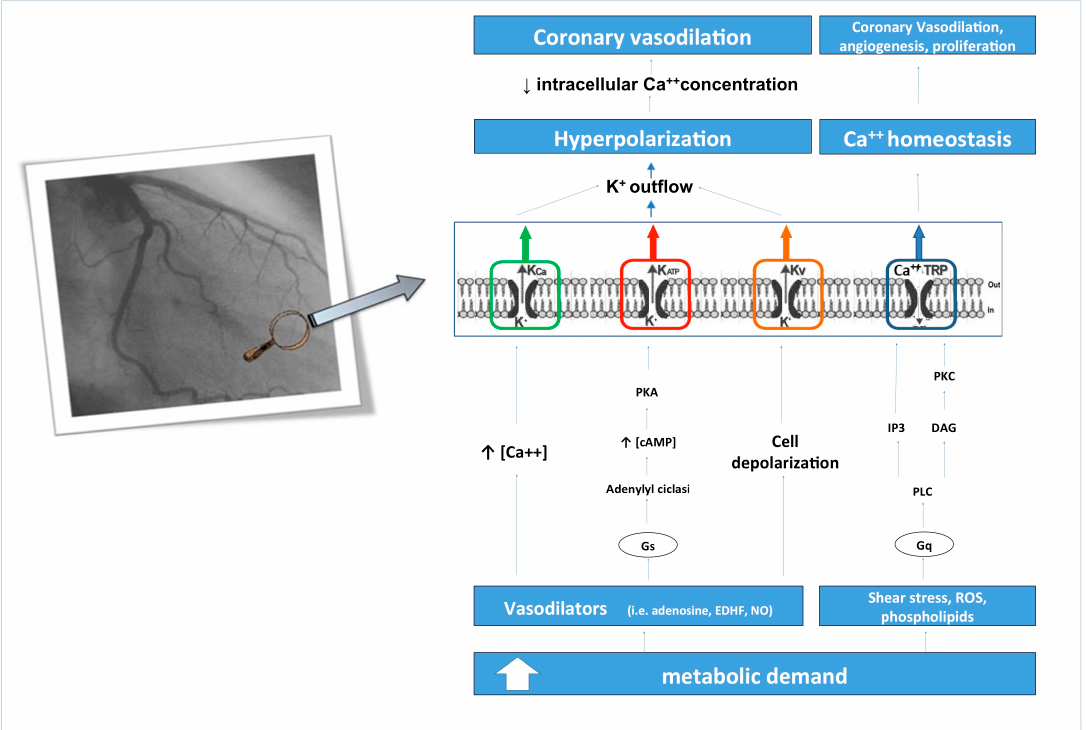
Figure 1. Represents the role of coronary ion channels matching coronary flow to metabolic demands, in coronary microcirculation. An increasing myocardial metabolic request requires an increase in coronary flow, through the action of various regulators in coronary microcirculation. As the metabolic demand increases, the coronary ion channels determine the hyperpolarization of the membrane and the closure of voltage-dependent Ca ++ channels. As a consequence, the concentration of intracellular Ca ++ decreases, and this leads to a decreasing tone of the coronary smooth muscle cell, resulting in the vasodilatory response. Abnormality function or expression of these ion channels, disturbing the communication between metabolism and coronary microcirculation, can lead to heart disease, ischemia and heart failure. KCa: potassium Ca ++ -activated channel; K ATP : ATP-sensitive potassium channels; Kv: voltage-gated potassium channels; TRP: transient receptor